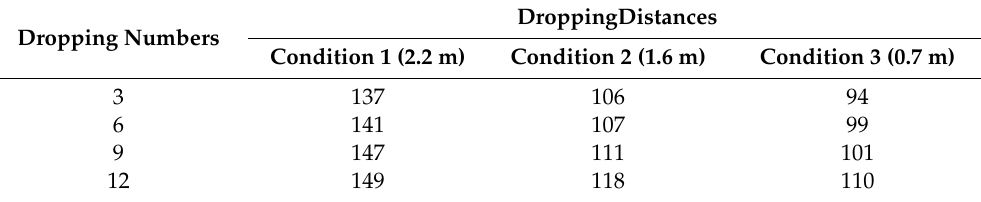
Table 2. E ff ective reinforcement depth (cm) under di ff erent working